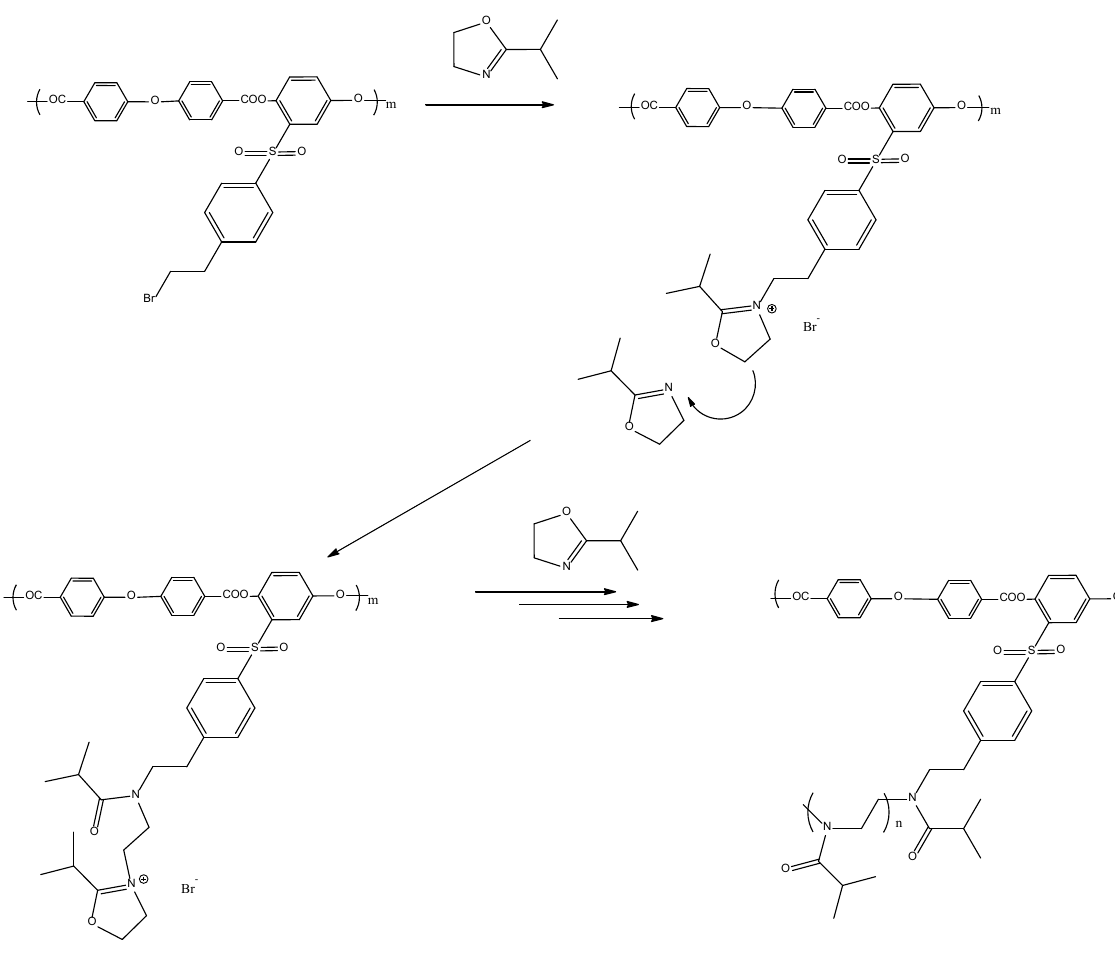
Figure 2. Synthesis of APE O -g-PiPrOx graft copolymers.